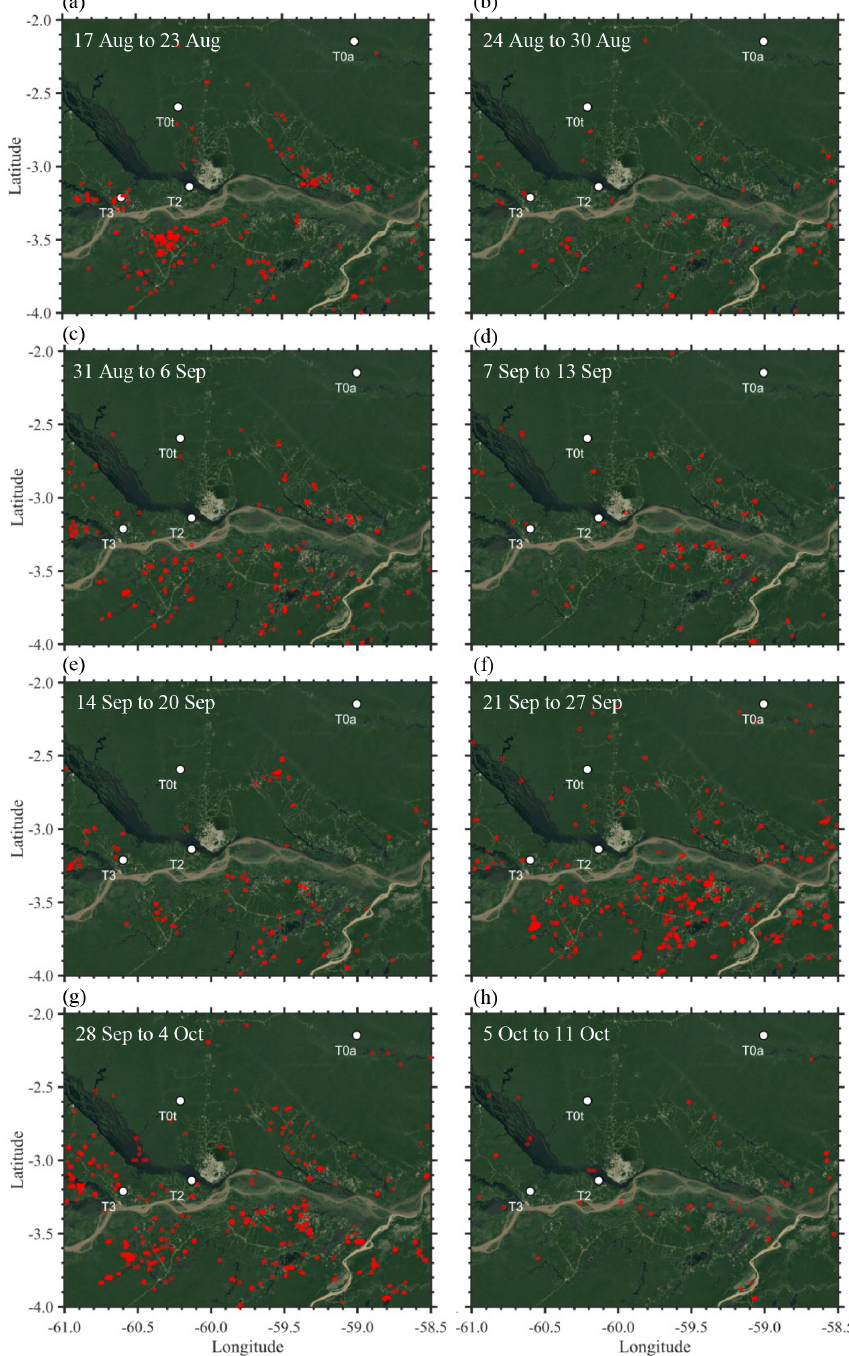
Figure 3. Fire locations in the upwind region of the T3 site for each week of IOP2. Transport times from the fires to the T3 site represent up to 15h at the scale of this figure and typical wind speeds. The plotted data were obtained from the fire database of the Brazilian National Institute of Spatial Research (INPE, 2018). Underlying image: Google